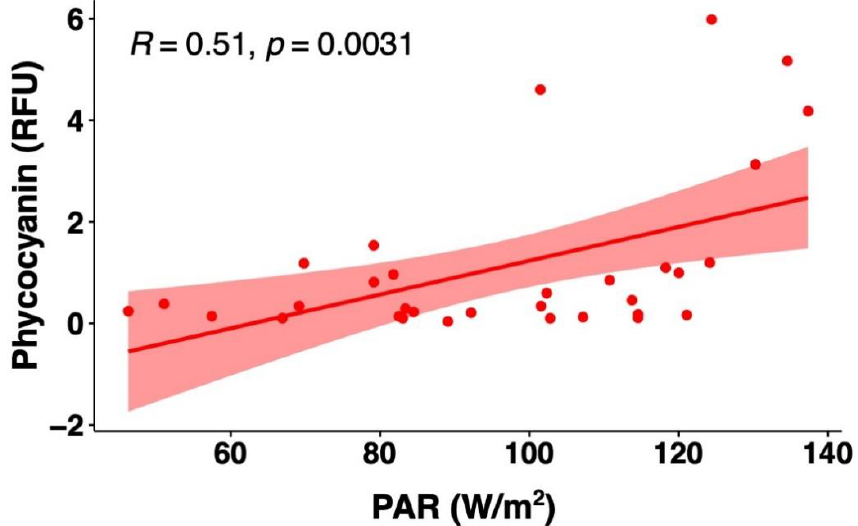
Figure 8. Correlations between photosynthetically available radiation (PAR) and phycocyanin probe readings for the raw water of Bedford DWTP during July and August of 2018. Shaded area around the line represents the 95% confidence interval.